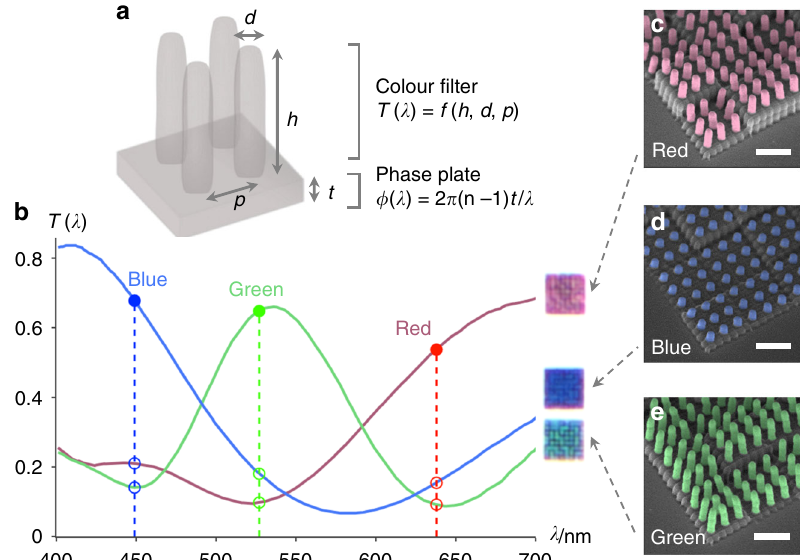
Fig. 2 Structure and characteristics of a holographic colour pixel. a Schematic of the structure of a holographic colour pixel that provides combined phase and amplitude control, comprising an array of pillars (colour fi lter) integrated on top of a block (phase plate) made of a dielectric material with refractive index n . The colour fi lter controls the amplitude of light based on its transmission spectrum T ( λ ) = f ( h , d , p ), which depends on the pillar array dimensions { h , d , p } (height, diameter, and pitch). The phase plate controls the phase of transmitted light where the phase shift arises from path length differences that depend on the block thickness. b Transmission spectra and corresponding optical micrographs of pillar arrays that serve as red, green and blue colour fi lters. Transmission spectra were averaged from measurements of pillar arrays with the same dimensions as those shown in the images, but patterned separately on blocks of uniform thickness (0.6, 1.0, 1.4, 1.8 μ m). Good RGB wavelength selectivity can be seen from the high transmittance (average 62%) for red (638 nm), green (527 nm), and blue (449 nm) light passing through matching colour fi lters ( fi lled circles), and low transmittance (average 15%) for light passing through mismatched fi lters (empty circles). c – e False-colour tilt-view SEMs of pillar arrays with dimensions optimised to give the best selectivity for red, green, and blue light. The pillars (~0.4 μ m in diameter and respectively 1.9, 0.7, and 2.6 μ m in height) are patterned in a square array of 1 μ m pitch onto 3 × 3 μ m 2 blocks of randomly varying thickness within the thickness range to be used for hologram phase plates (0.6 – 1.8 μ m). Scale bars are 2 μ